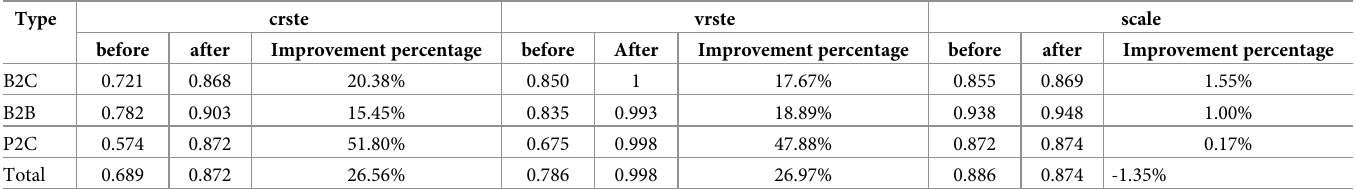
Table 5. Comparison of technical efficiency before and after adjustment of the input variables of three types of e-commerce firms in 2019. Type crste vrste scale before after Improvement percentage before After Improvement percentage before